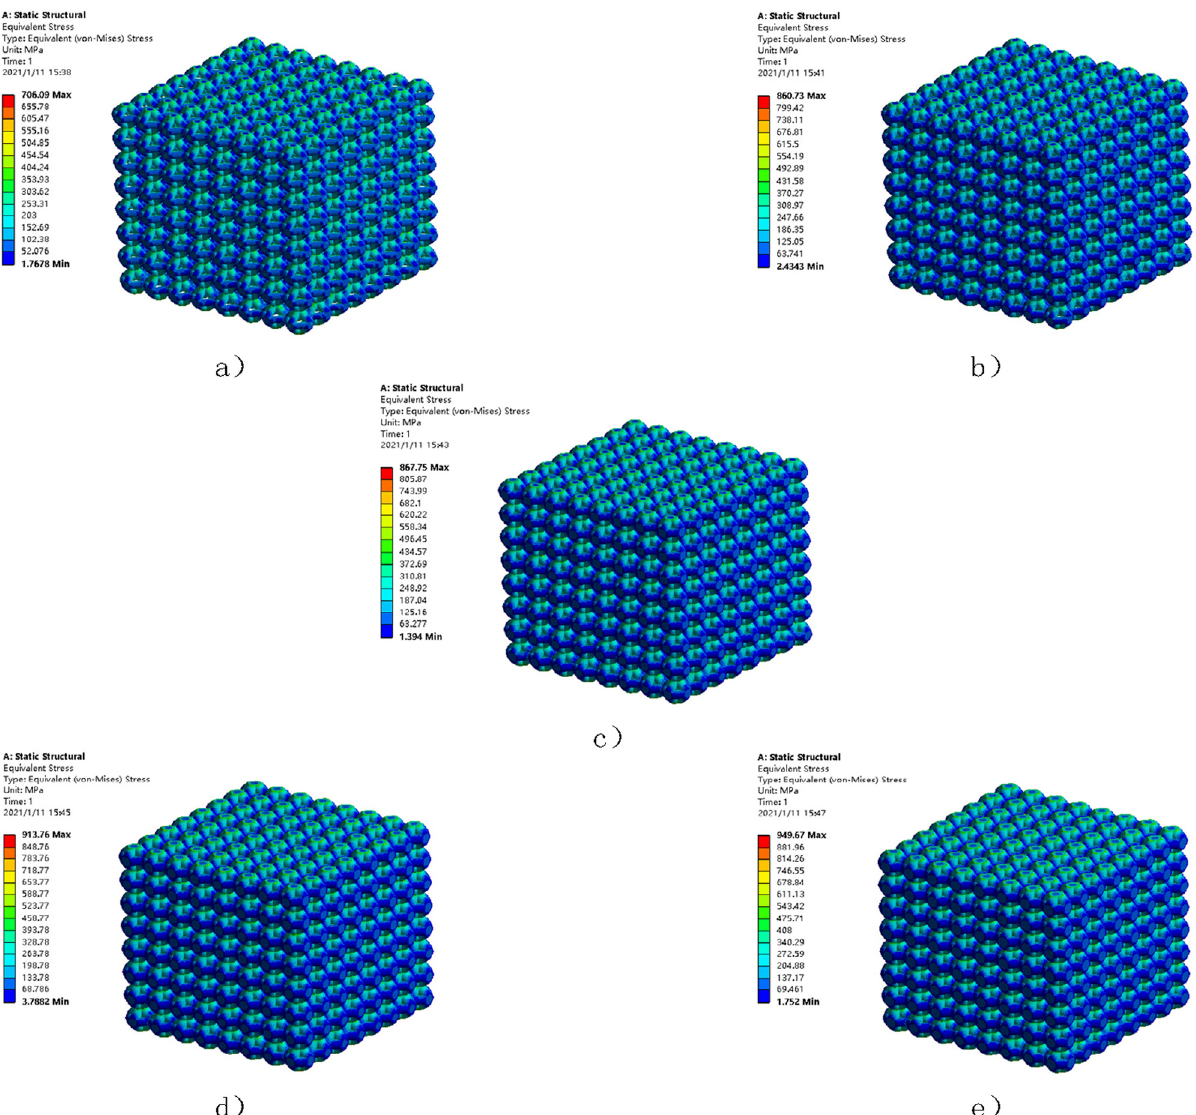
Figure 5: Stress distribution of 1.5 mm cell loaded with di ff erent edge diameters ( a ) 0.4 mm edge diameter stress map; ( b ) 0.45 mm edge diameter stress map; ( c ) 0.5 mm edge diameter stress map; ( d ) 0.55 mm edge diameter stress map; and ( e ) 0.6 mm edge diameter stress